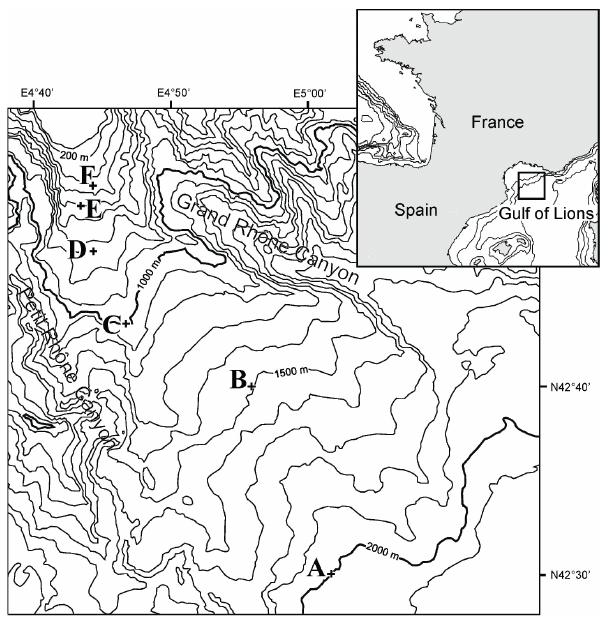
Figure 1. Location map showing sampling stations and